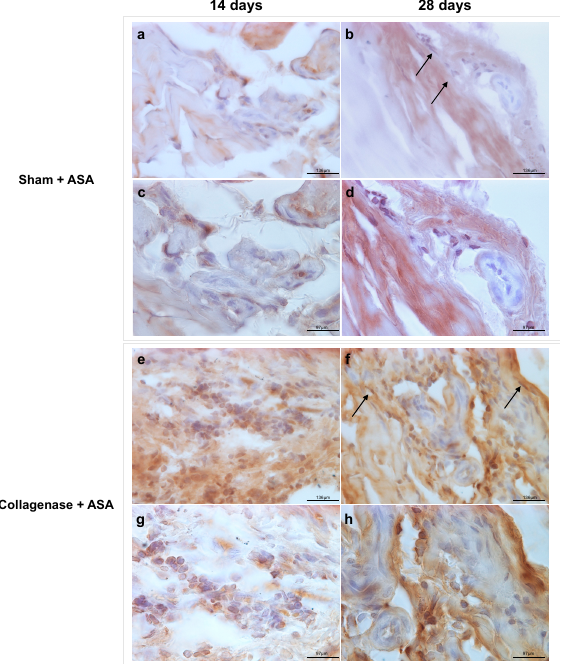
Figure 5. Anti-human nuclei clone 3E1.3 immunohistochemical (IHC) staining in the amniotic suspension allograft (ASA) treated groups for the presence of ASA at each time point. For 14 days, ( a ) and ( c ) denote sham/ASA, while ( e ) and ( g ) denote collagenase/ASA. For 28 days, ( b ) and ( d ) denote sham/ASA, while ( f ) and ( h ) denote collagenase/ASA. Scale bars for ( a ), ( b ), ( e ), ( f ) indicates 136 μ m, while scale bars for ( c ), ( d ), ( g ), ( h ) indicates 97 μ m. Black arrows indicate postively-stained cells, indicating the retention of ASA in the tendon at the specific time point.